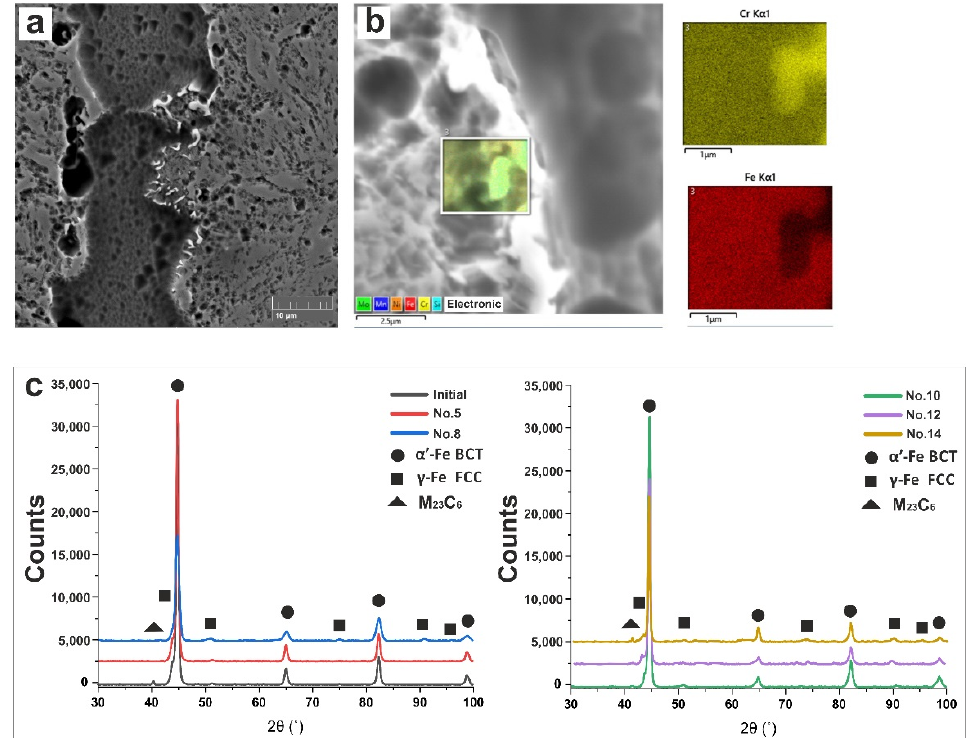
Figure 8. Hardness graph of hardened samples.